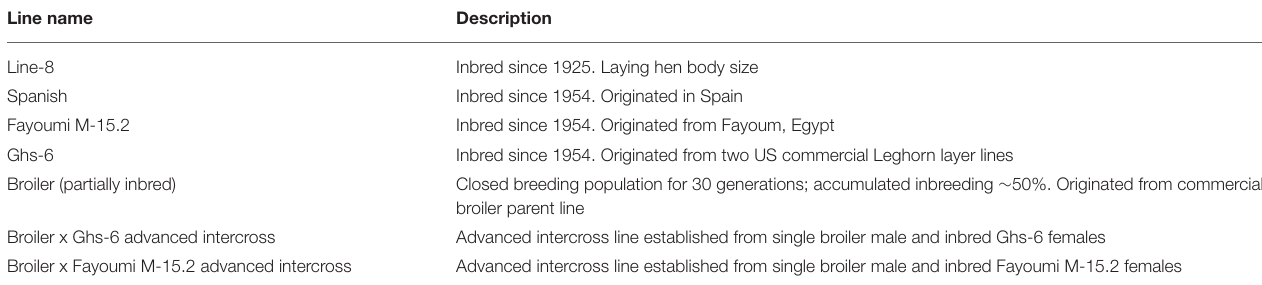
TABLE 1 | Name and description of each of the genetic lines utilized for metabolic comparison with modern commercial layer and broiler